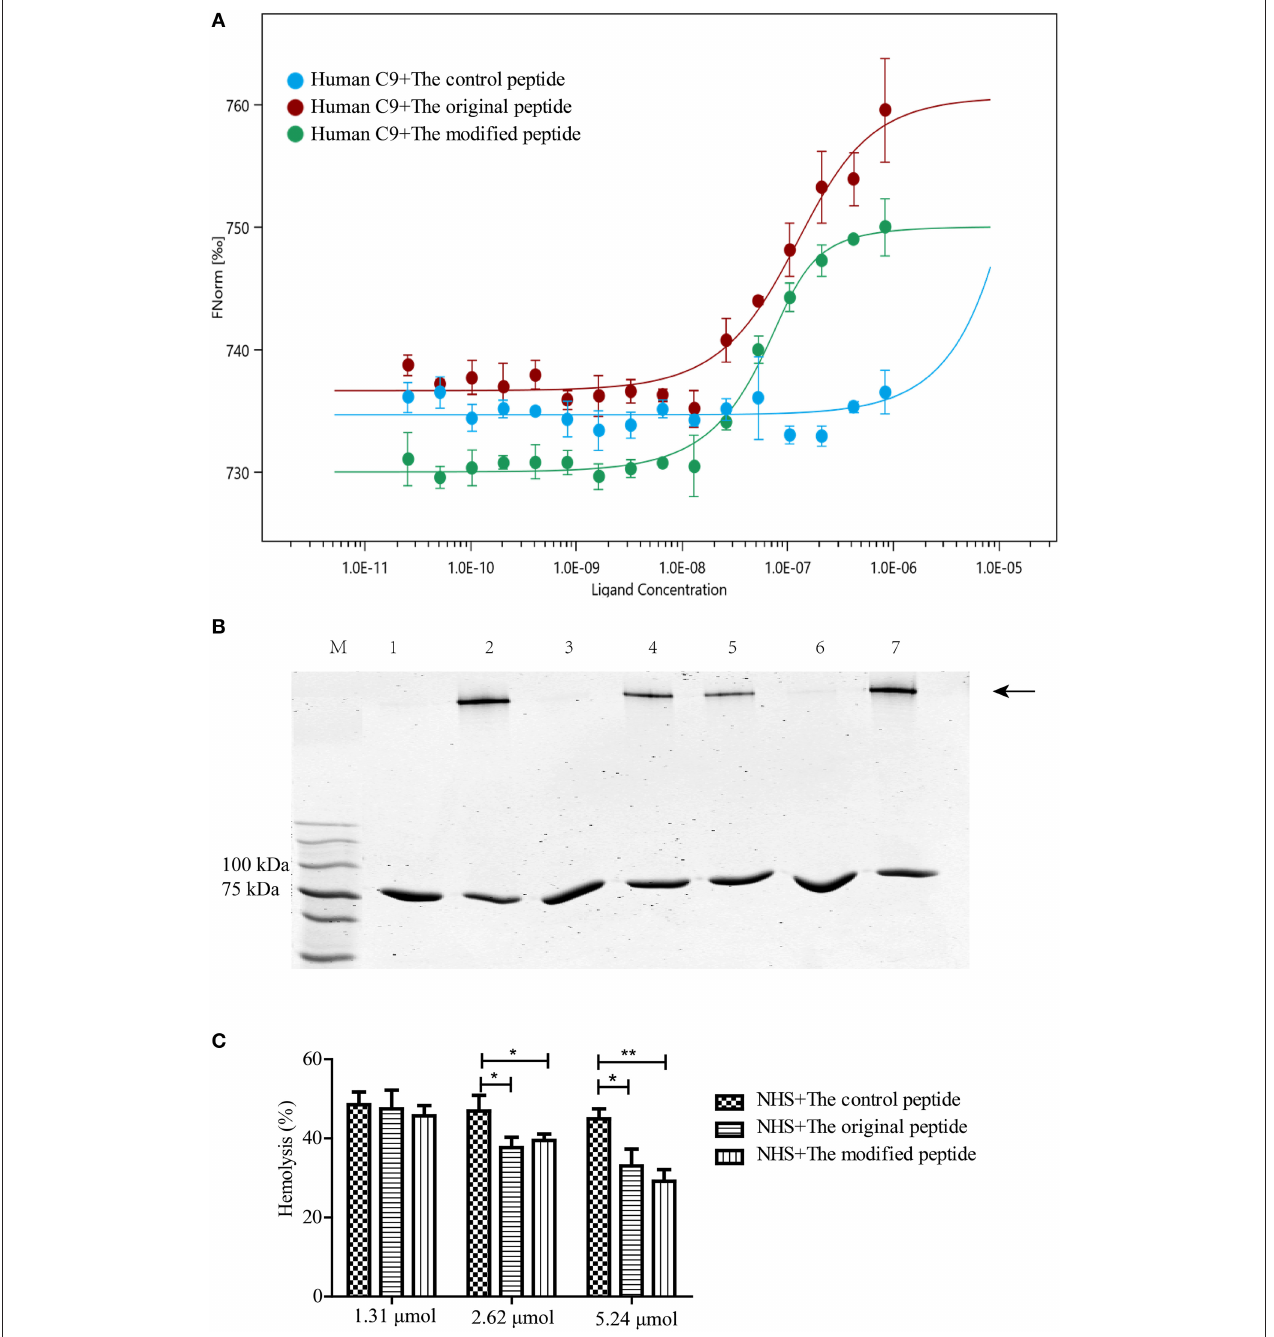
FIGURE 1 | Modified peptide bound to human complement C9 and inhibited C9 polymerization-induced bio-function. (A) Microscale thermophoresis assay (NanoTemper) in which biomolecular interactions were quantitated by examining the motion of the molecules along a microscopic temperature gradient induced by an infrared laser. Changes in the molecular hydration shell, charge, or size are measured using a fluorescent probe (NT-647) bound covalently to the human C9. Binding of control, modified and original peptides to human C9 were studied. Data points indicate the differences in normalized fluorescence (%) generated by peptides binding to mouse C9, and curves indicate the calculated fits. There was a concentration-dependent binding between the human C9 and the original or modified peptide instead of the control peptide. Error bars represent the standard error of three independent measurements. (B) Zn 2 + -induced C9 polymerization (indicated by the arrowhead) was inhibited in a dose-dependent manner by the modified peptide [slightly by 2.62 µ mol (lane 5) and completely by 5.24 µ mol (lane 6)] compared to the control peptide [5.24 µ mol (lane 7)] or the original peptide [5.24 µ mol (lane 3)]. Lane M: standard protein markers; lane 1: blank control (C9 without Zn 2 + ); lane 2: positive control (C9 with Zn 2 + ); lane 3: 5.24 µ mol original peptide; lanes 4–6, 1.31, 2.62, and 5.24 µ mol modified peptide, respectively; lane 7, 5.24 µ mol control peptide. (C) Normal human serum (NHS)-induced complement-mediated hemolysis was inhibited by the modified and original peptides (2.62 and 5.24 µ mol) compared to the control peptide. All experiments were performed three times and data are presented as mean ± SD. * p < 0.05, ** p < 0.01.